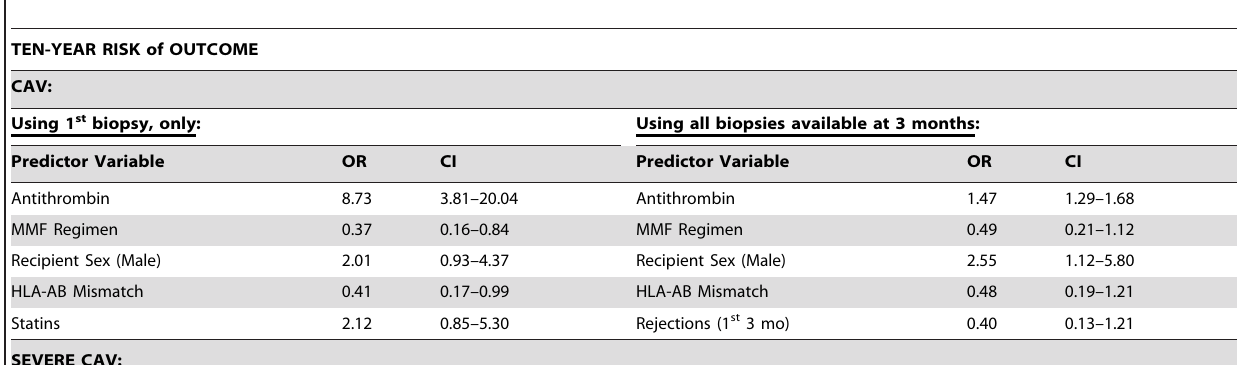
Table 5. Final multivariate logistic regression models using first-biopsy-only or three-month biopsy data to predict CAV, severe CAV, and graft failure due to CAV at ten years